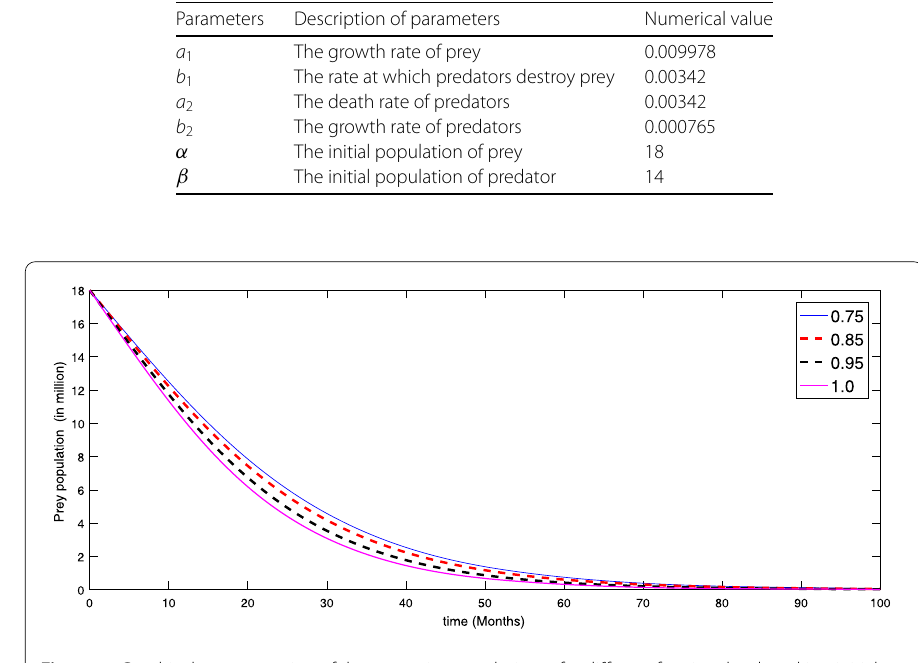
Figure 1 Graphical representation of the approximate solution u for different fractional order taking initial ten terms of the series in Case